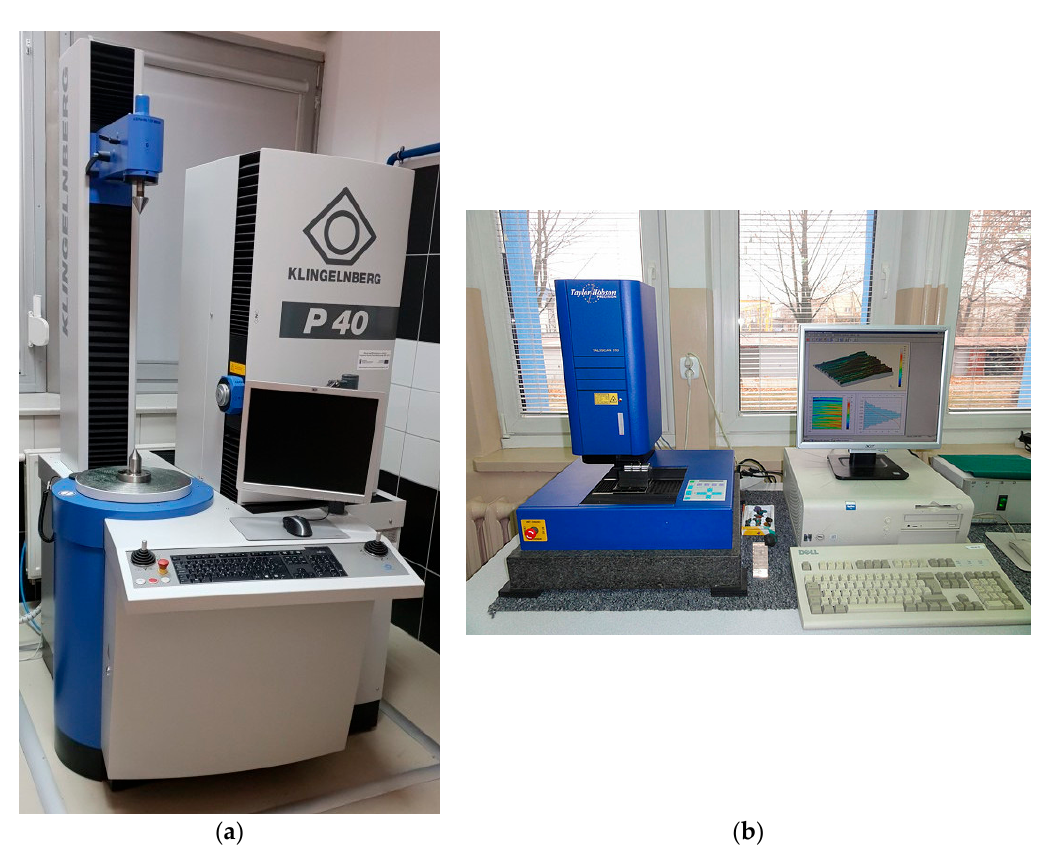
Figure 7. Tooth surface topography assessment instruments: ( a ) P40 CMM; ( b ) TalyScan 150.